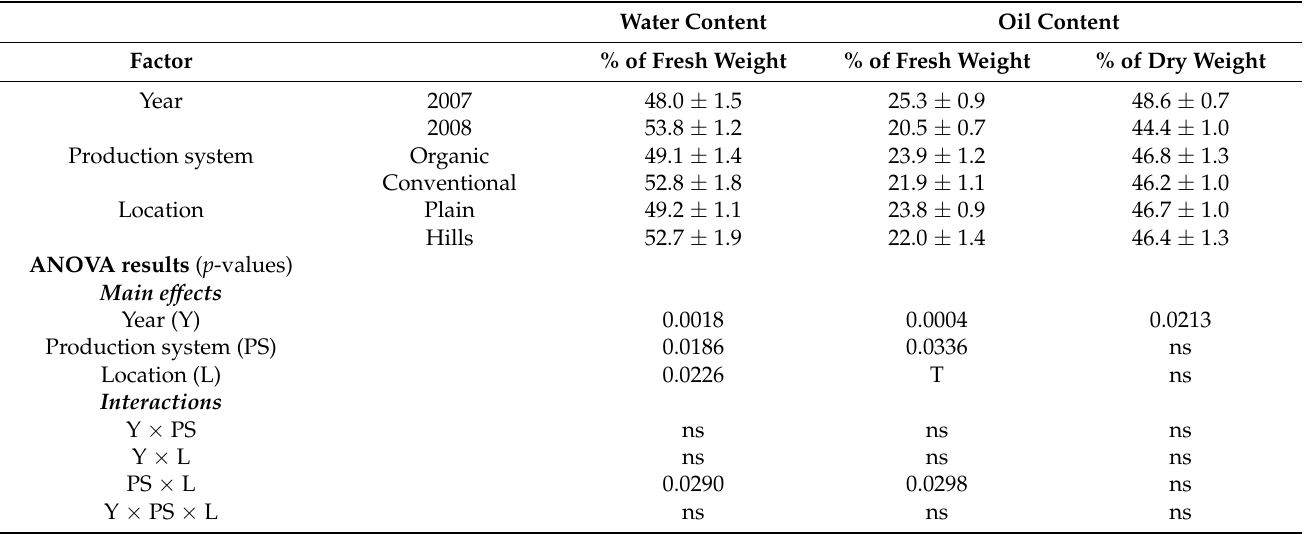
Table 3. Effect of, and interaction between, harvest year (2007, 2008), production system (organic versus conventional) and location of fields (plain versus foot hills) on olive fruit composition. Water Content Oil Content Factor % of Fresh Weight % of Fresh Weight % of Dry